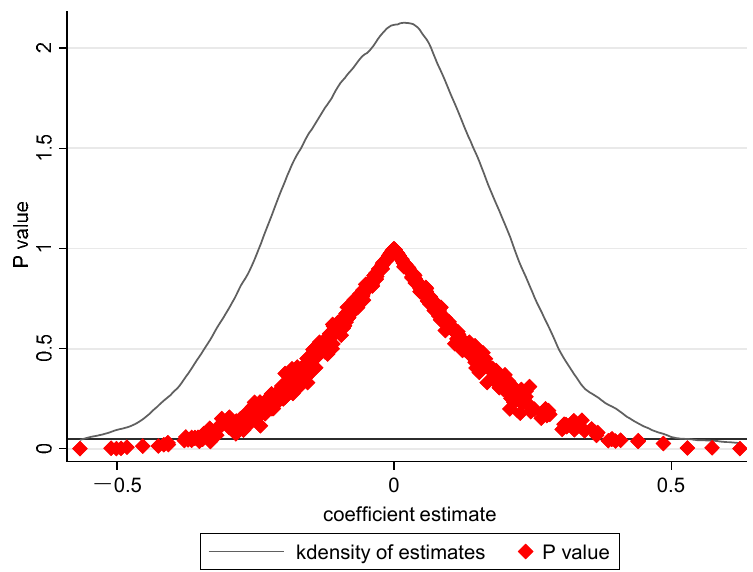
Figure 4. Placebo test.